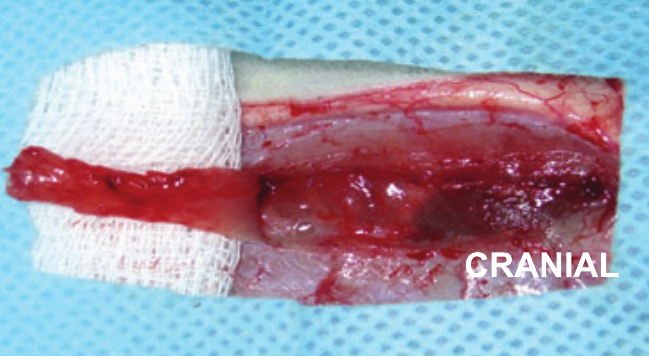
FIGURE 4 – Group E- anterior abdominal wall of rat displaying caudal devascularization of the right rectus abdominis muscle, reflected in the caudocranial direction.